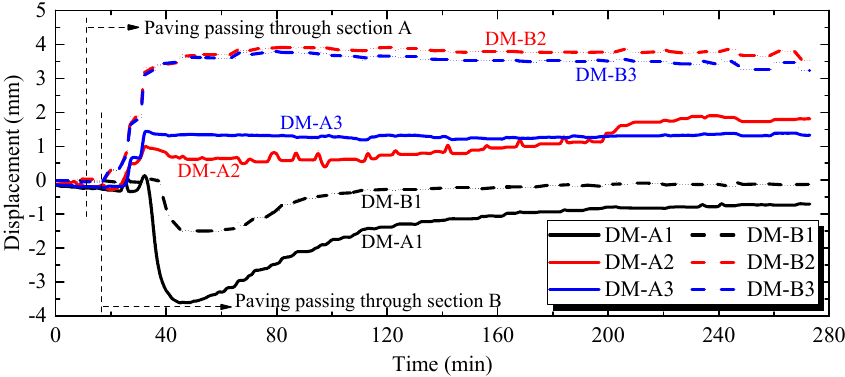
Figure 6. Monitored displacement of the bearings during the paving process.